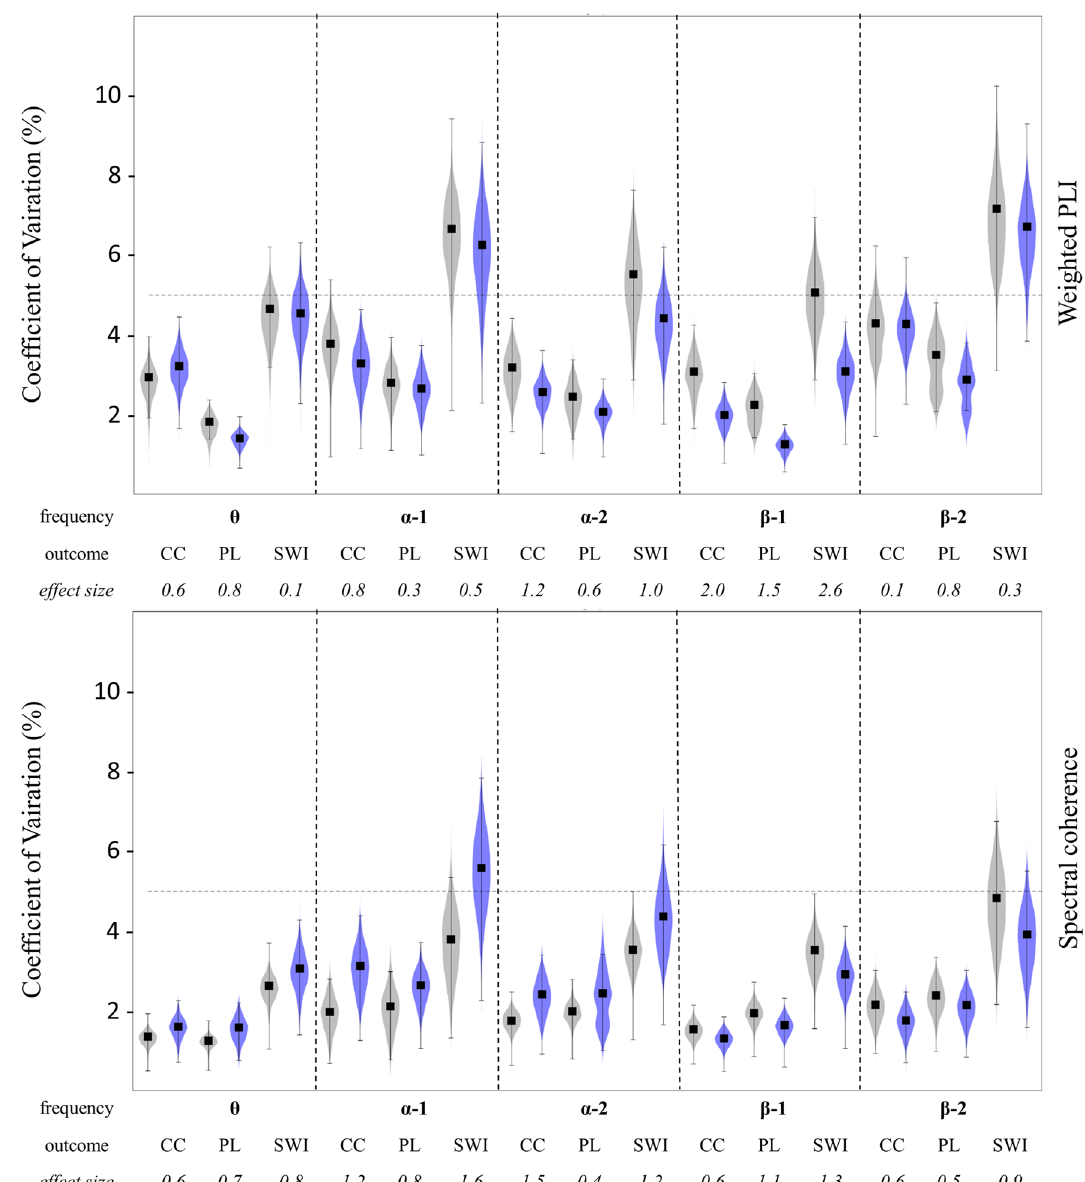
k CoV values per condition. Black squares indicate the CoV values of the original sample, brackets indicate the 95% confidence intervals. CC clustering coefficient, PL characteristic path length, SWI small-world index. Graph measures are computed for theta (θ, 4 to 8 Hz), alpha-1 (α-1, 8 to 10.5 Hz) and alpha-2 (α-2, 10.5 to 13 Hz), beta-1 (β-1, 13 to 20 Hz) and beta-2 (β-2, 20 to 30 Hz) frequency bands. Horizontal line indicates the 5% threshold for CoV